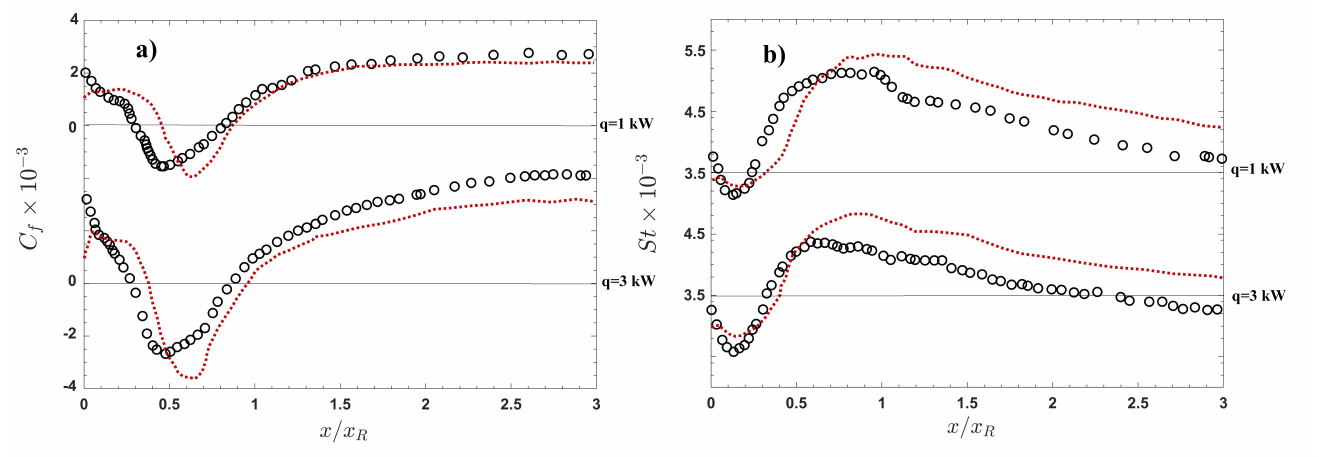
Figure 10. The mean velocity and Reynolds shear stress in various streamwise location for the isothermal wall case. IDDES (red dotted line), LES (blue dashed line), and corresponding experiment (circles).